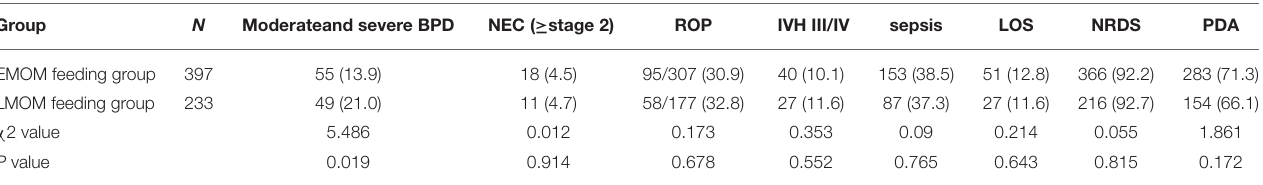
TABLE 2 | Comparisons of the occurrence of VLBW infants between the two groups (Example [%]).